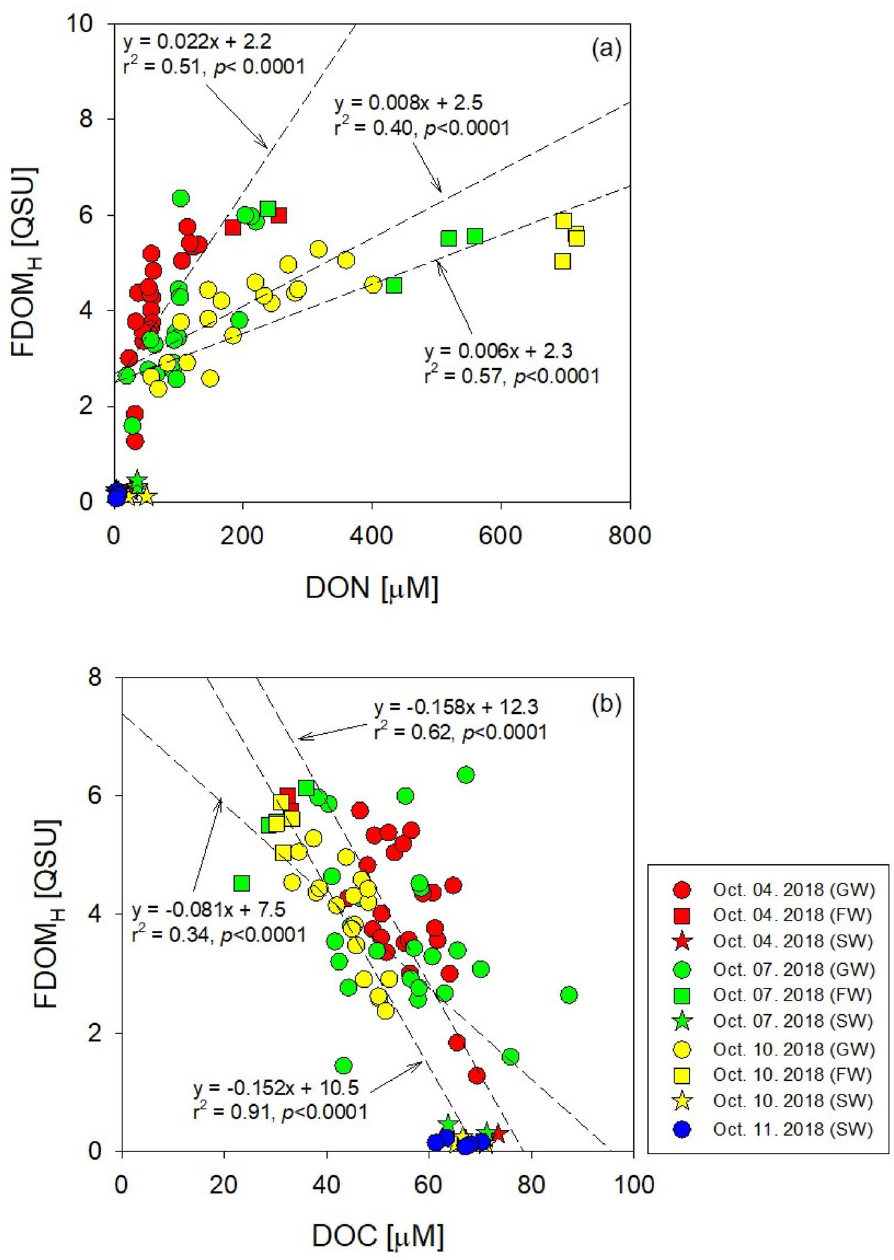
Figure 3. Scatter plots of humic-like fluorescent dissolved organic matter (FDOM H ) versus ( a ) dissolved organic nitrogen (DON) and ( b ) carbon (DOC). This figure was drawn with sigma plot software (ver.